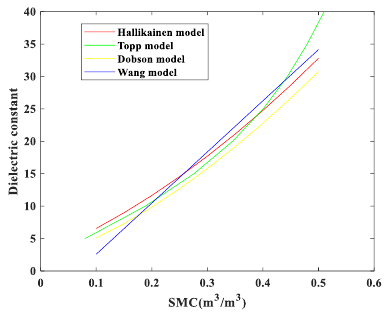
Figure 6 . The four soil models on international loamy clay （ C=0.35 ， S=0.33 ） .